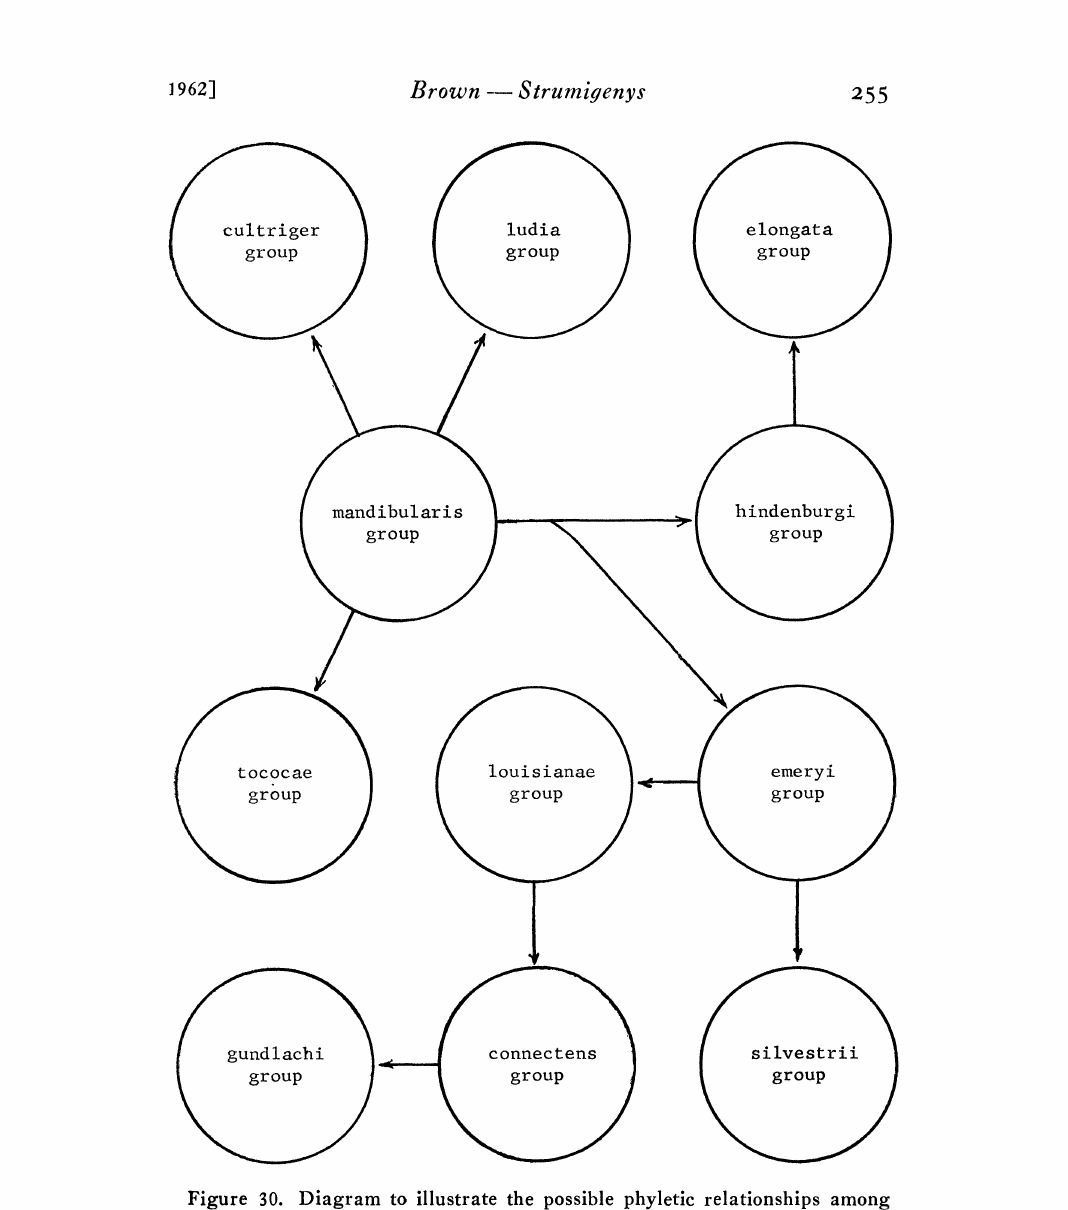
Figure 30. Diagram to illustrate the possible phyletic relationships among the species-groups of New World Strumigenys, based upon the hypothesis that the group of 8. mandibularis represents the primitive stock in this hemisphere. 8. rogeri, being African in origin, does not figure in this